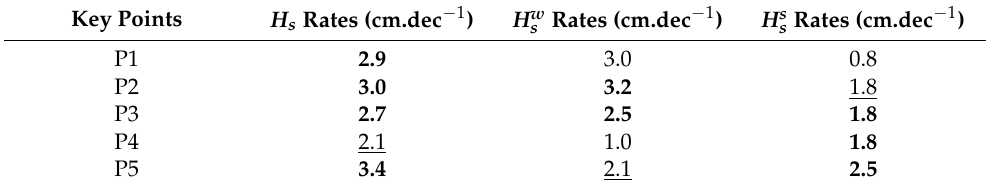
underlined and for 99% are in